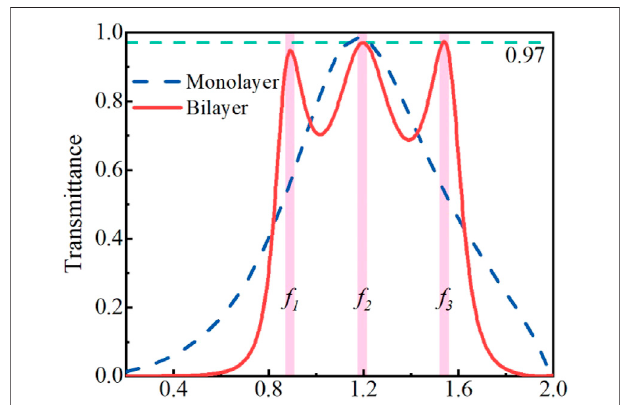
FIGURE 2 | Simulated transmission spectra of the monolayer structure (the blue dash line) and bilayer structure (the red solidline). Three transmission peaks are 0.89, 1.19, and 1.54 THz,